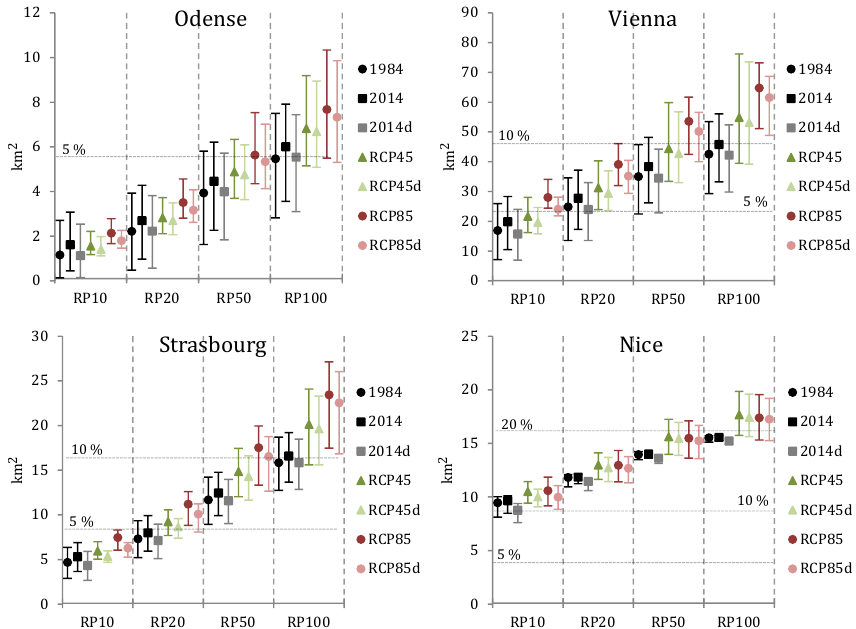
Figure 7. Total area flooded by more than 10cm of surface water as a result of extreme precipitation events of different return periods (RP 10–RP 100); the years indicate the observed configurations of impervious surfaces in 1984 and 2014 respectively. 2014d is the drainage system updated to follow changes in imperviousness caused by urban development. RCP 45d and RCP 85d represent the drainage system updated to follow changes in precipitation intensities caused by climate change. Error bars represent low/high infiltration rates and low/high climate factors (CFs) respectively (low CF is in the 10th percentile and high CF is in the 90th percentile). The horizontal percentage lines highlight the share of the total urban area in each